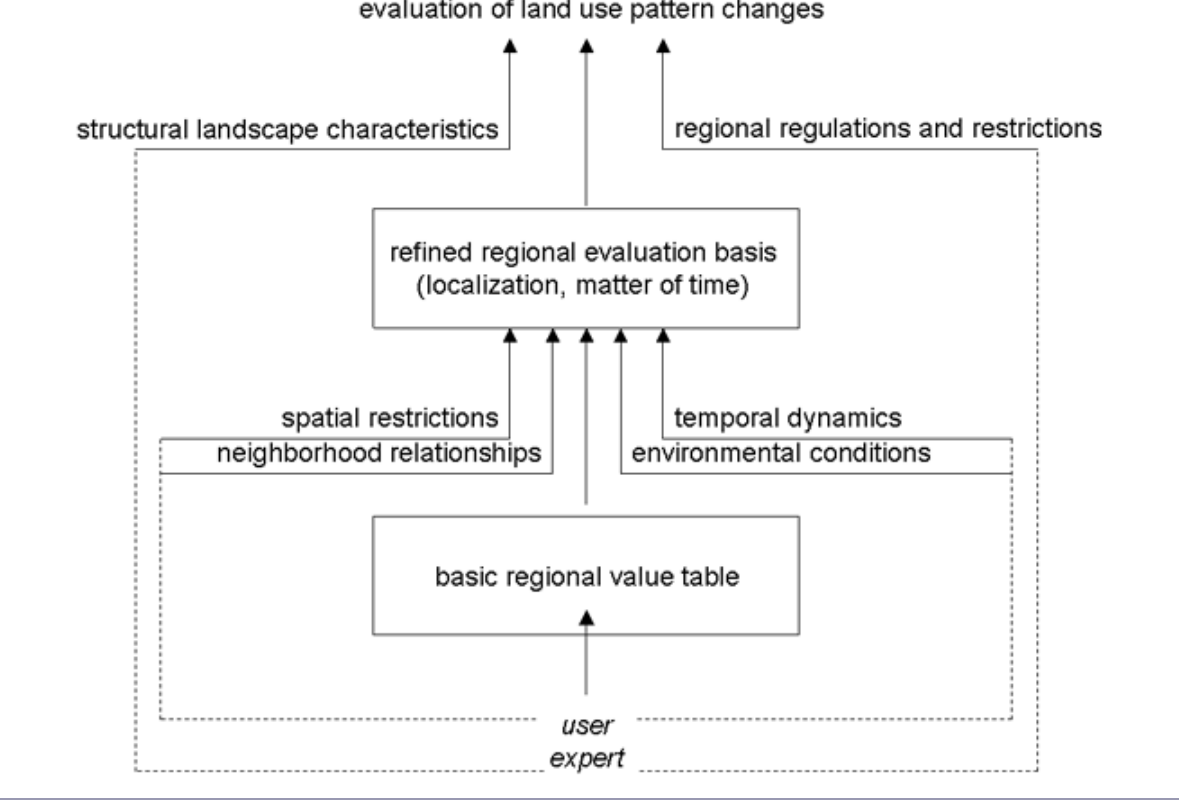
Fig. 2 . Connection between value table, rule sets, and evaluation results in Pimp your landscape